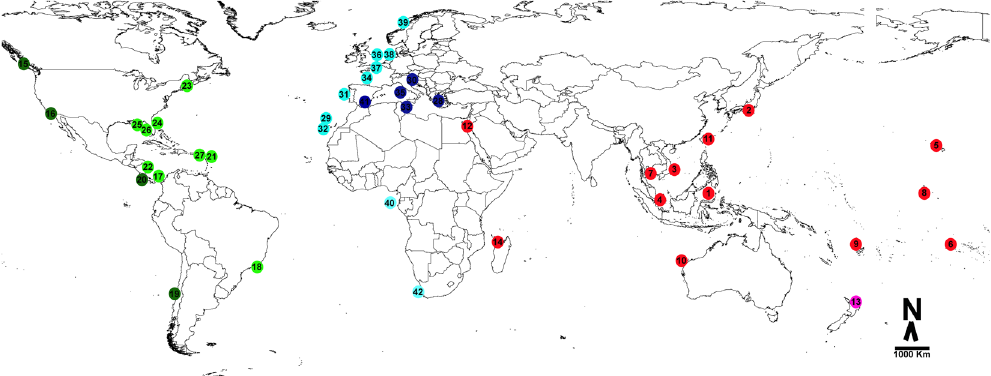
Figure 1. Sampling locations of specimens included in the analyses; see Supplementary Table S1 for details. The map was built with a template of the software Diva-Gis 7.5 74